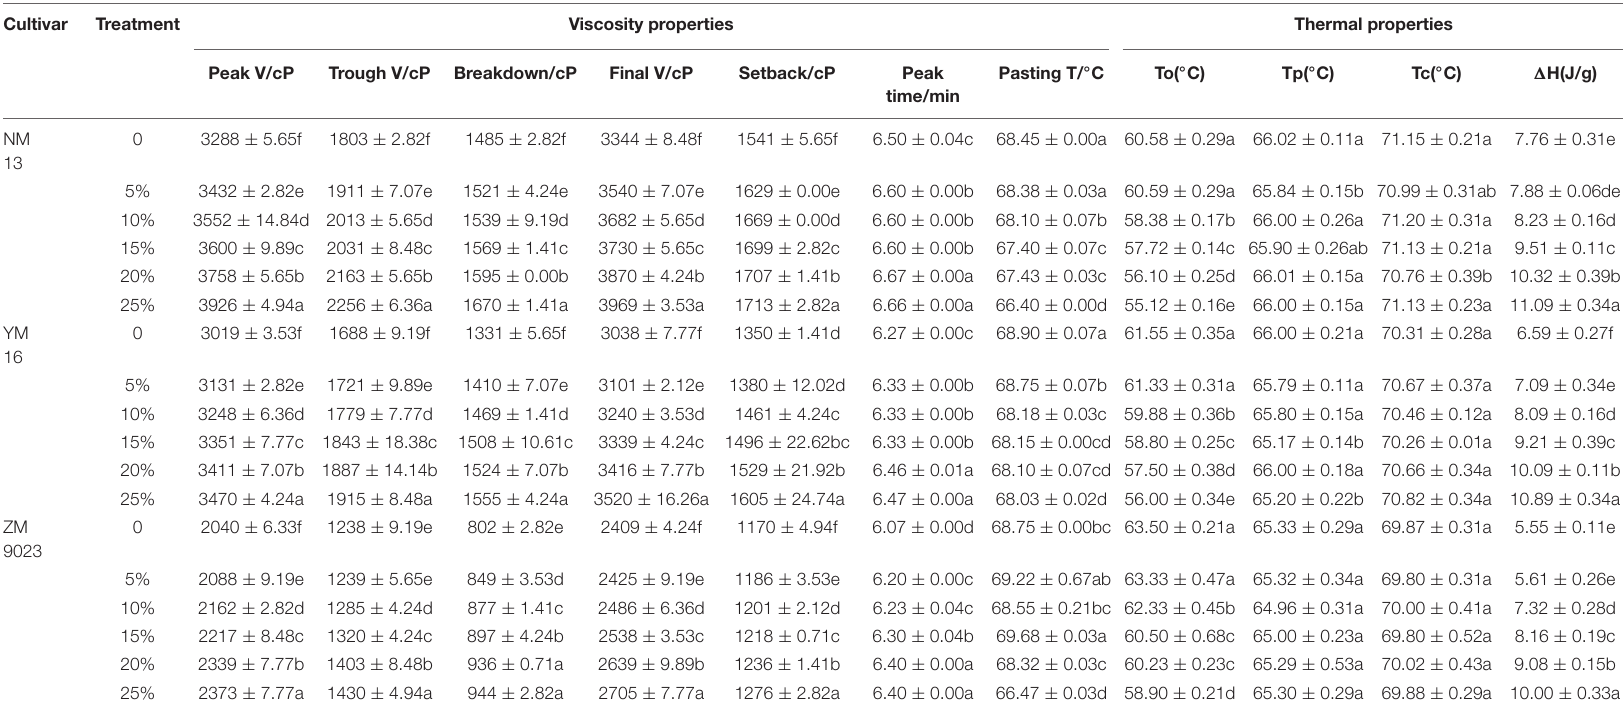
TABLE 1 | Effect of additional amount of starch on starch component, pasting, and thermal properties of wheat.